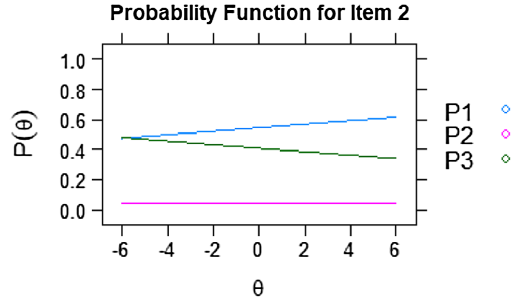
FIG. 6. Probability function of item Q2. P1 (blue) indicates 0 points, P2 (pink) 1 point, and P3 (green) 2 points scored. The axes represent the learner ’ s ability ( x axis, theta) and the probability of solving this item correctly ( y axis).